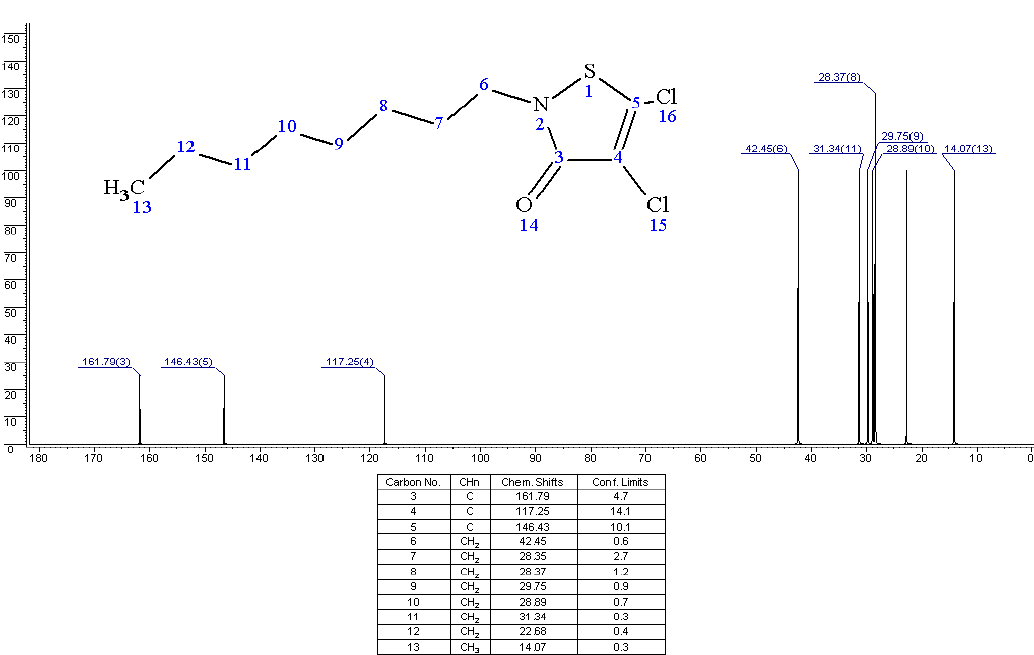
Figure 4. 13 C NMR spectra of DCOIT.